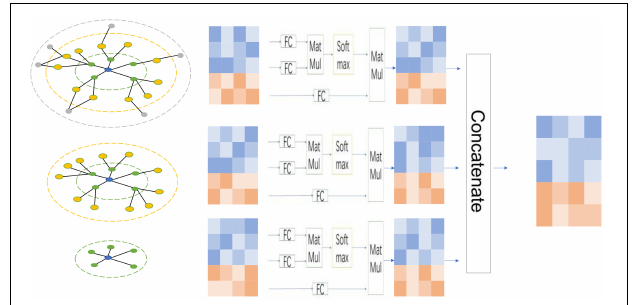
FIGURE 2 | Multi-layer concatenates. For each node-attention and feature-attention, the node information has different structural information. By fusing the features of each layer of nodes based on the two attention mechanisms, it can effectively use these node features integrating different structural